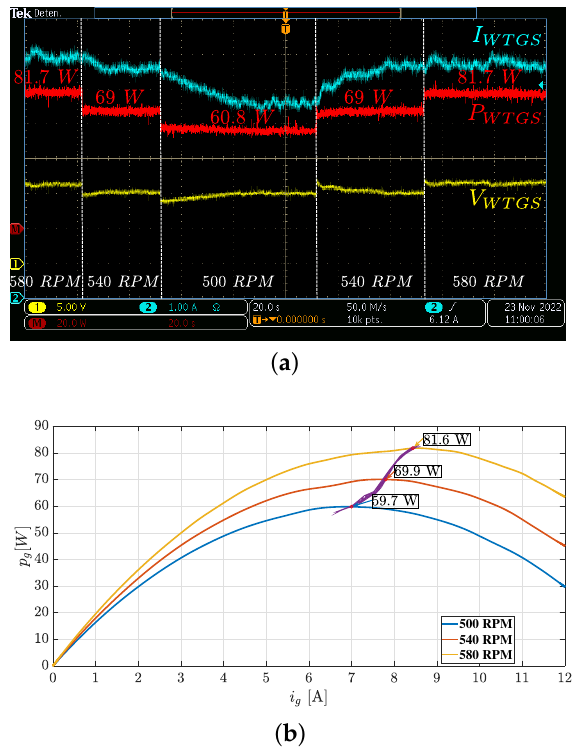
Figure 12. Experimental performance of the complete small wind generation system with a grid connection. ( a ) MPPT tracking for variable speed profile. ( b ) Tracking path of the MPP